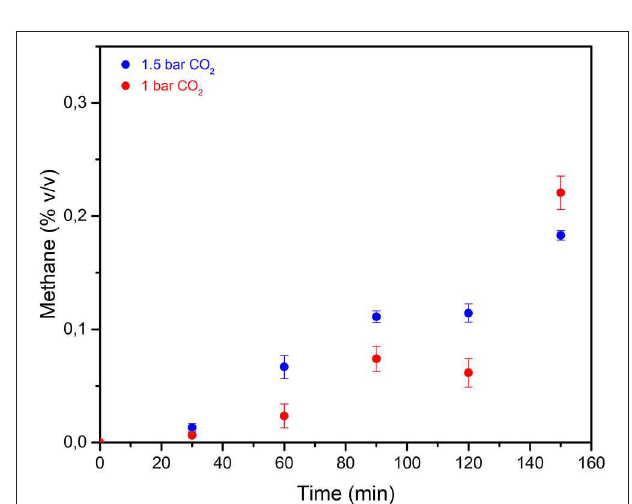
FIGURE 6 | H 2 concentration in the gas phase within the mechanochemical reactor, as registered at different times of mechanical treatment, in the tests carried out with a pressure head of 1.5 bar of CO 2 .